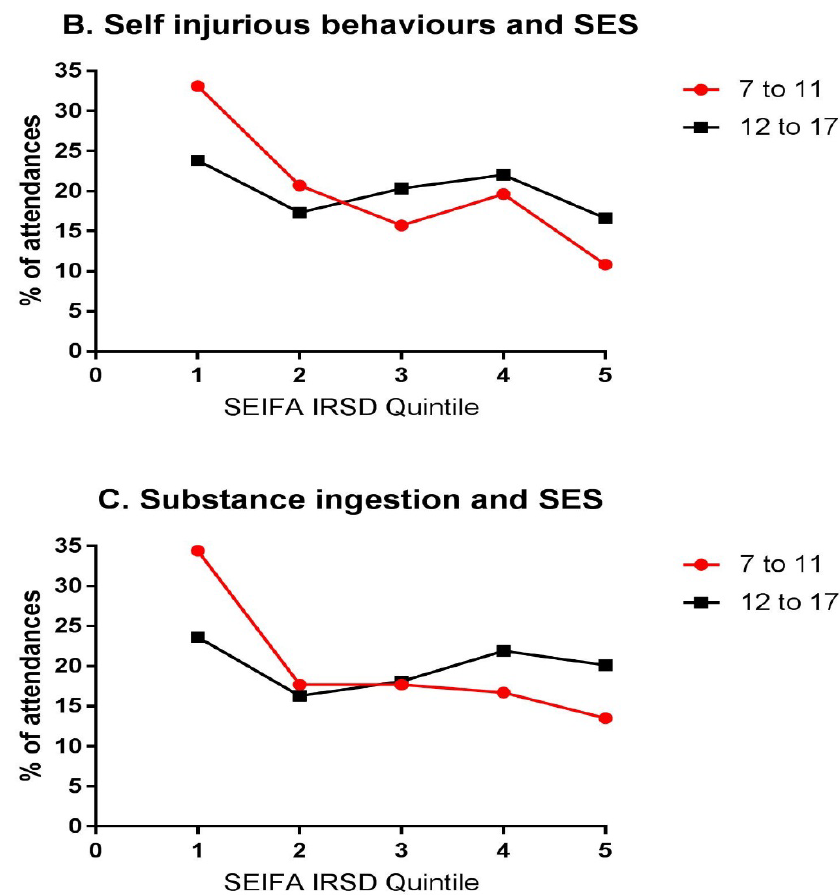
Figure 4. Ambulance attendances as a function of SEIFA-IRSD quintile for mental health ( A ); self-injurious behaviour ( B ); and substance ingestion ( C ). An SES gradient is more evident in the 7–11 age group for self-injurious behaviour, compared to those aged 12–17; however, there are no significant differences for the effect of SES between two age groups on mental health or substance ingestion. SES: Socio-economic status.